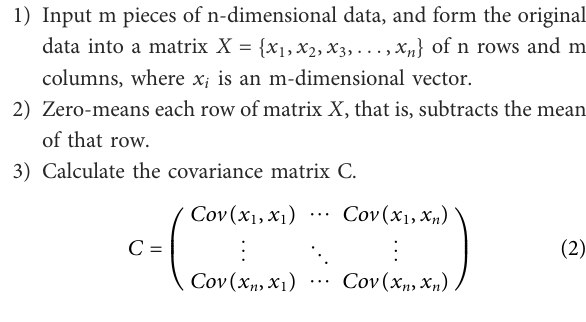
Algorithm 1. Subsequence segmentation and feature extraction.